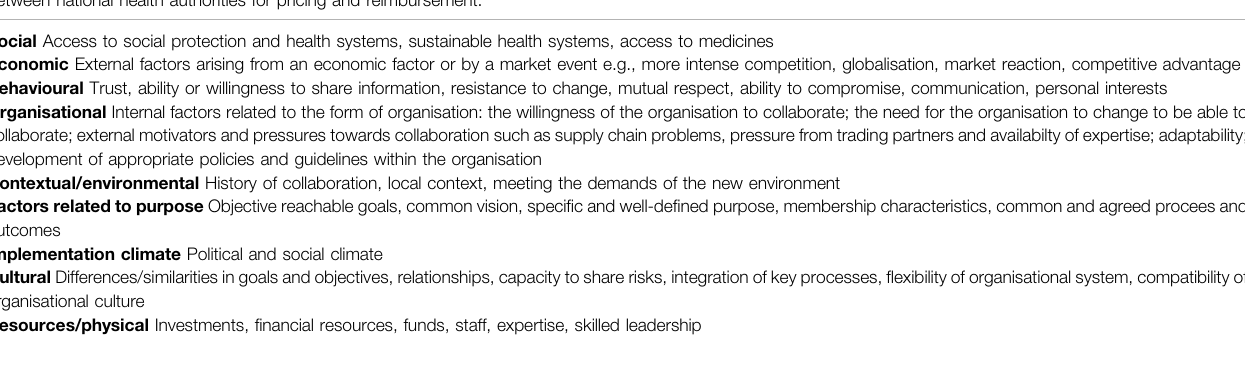
TABLE 2 | Motivational factors which act as barriers (negative motivators, challenges) and factors which act as facilitators (positive motivators, drivers) for collaboration between national health authorities for pricing and reimbursement. Social Access to social protection and health systems, sustainable health systems, access to medicines Economic External factors arising from an economic factor or by a market event e.g., more intense competition, globalisation, market reaction, competitive advantage Behavioural Trust, ability or willingness to share information, resistance to change, mutual respect, ability to compromise, communication, personal interests Organisational Internal factors related to the form of organisation: the willingness of the organisation to collaborate; the need for the organisation to change to be able to collaborate; external motivators and pressures towards collaboration such as supply chain problems, pressure from trading partners and availabilty of expertise; adaptability; development of appropriate policies and guidelines within the